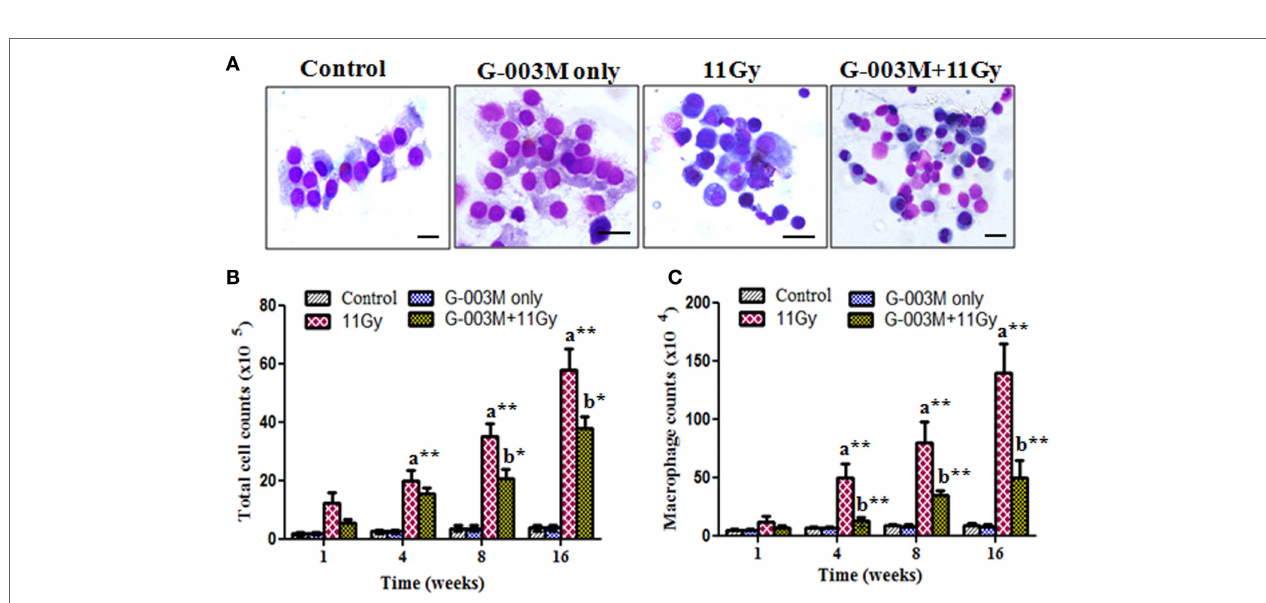
FigUre 5 | Effect of G-003M on bronchoalveolar lavage fluid (BALF) of irradiated mice. (a) Representative images of May-Grünwald–Giemsa stained cells from BALF of differentially treated mice. Control and G-003M only groups showing normal epithelial cells and macrophages. Enhanced number of inflammatory cells in BALF of 11 Gy thoracic-irradiated mice. Noticeable reduction in the number of these inflammatory cells in G-003M-pretreated irradiated group. Magnification 1,000 × . (B) Total BALF cellular counts and (c) macrophages counts in BALF. Scale bar 10 µm. Data are represented as means ± SEM from six mice for each group. a = 11 Gy vs. controls, b = G-003M + 11 Gy vs. 11 Gy. * p < 0.05; ** p <